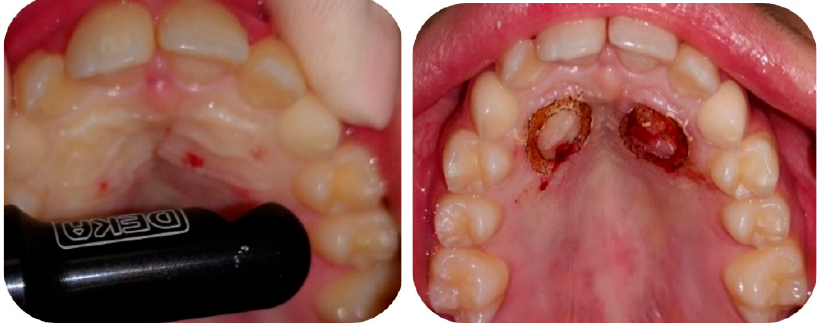
Figure 2. The tip of the CO 2 laser is used near to the tissue surface ( left ); Operculum performed with CO 2 laser ( right ).